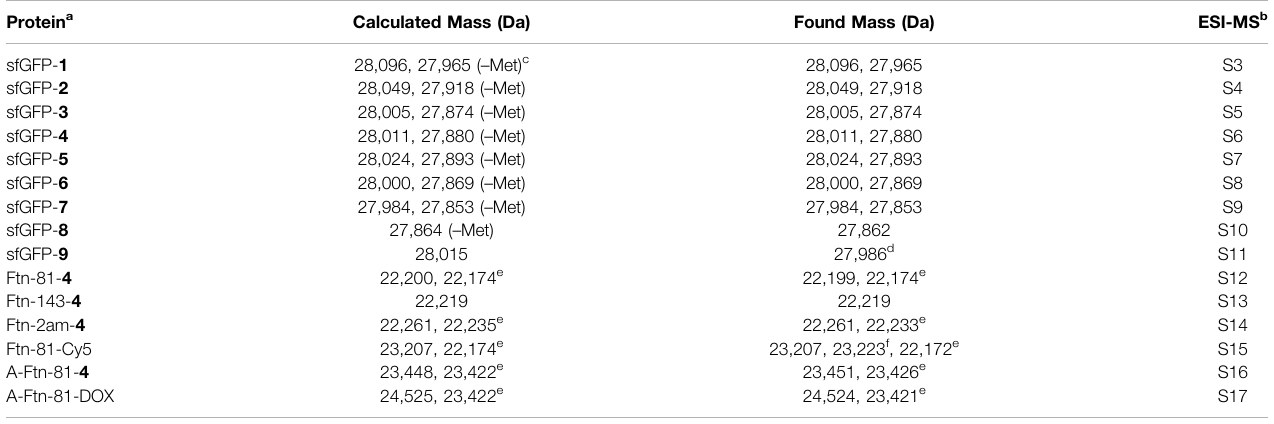
(cid:129) tRNA Pyl pair.